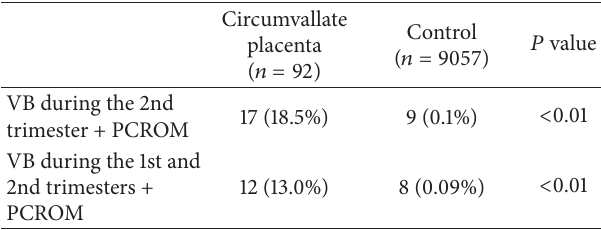
Table 5: Comparison of clinical symptom rates between circumval- late placenta and control